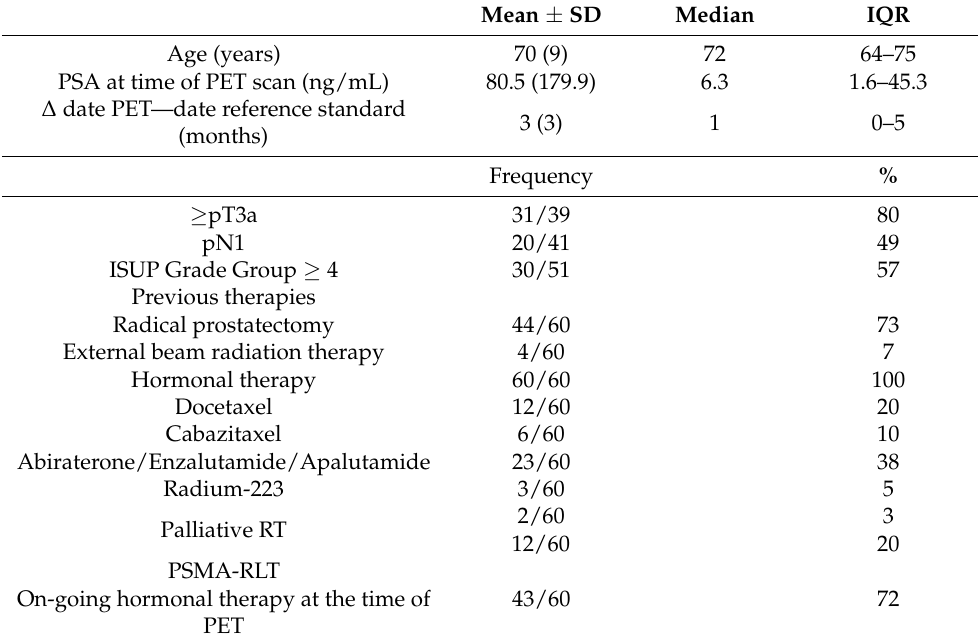
Table 1. Patient